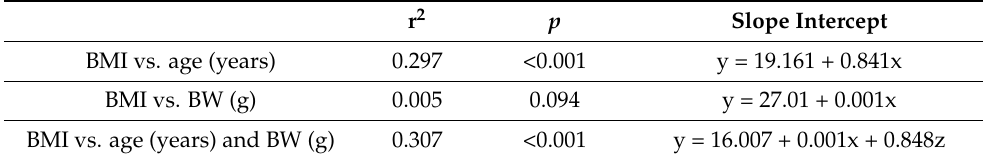
Table 2. BMI regression analysis.